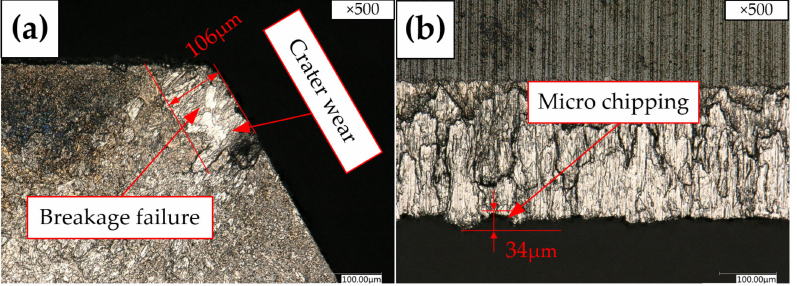
Figure 6. Tool wear morphologies with KEYENCE microscope of Tool B: ( a ) Rake face; ( b )